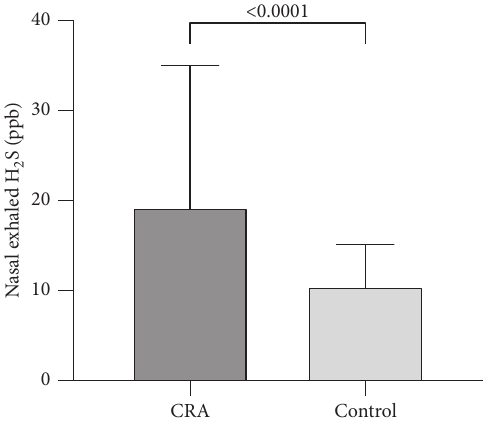
Figure 1: Nasal exhaled H 2 S comparison between the observation group and control